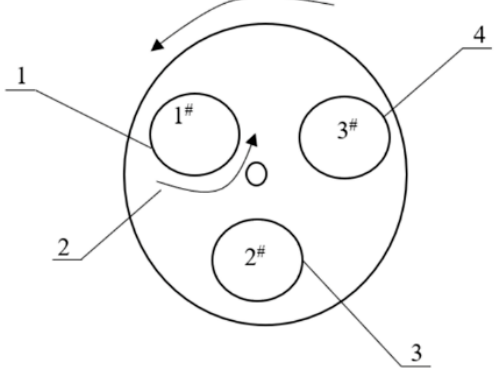
Figure 7. Rotary table Zeng with three working stations (1: steamer-filling station; 2: rotation of Zeng; 3: distillation station; 4: discharging station for distilled grains) Reprinted with permission from [39] Copyright 2021 from authors.